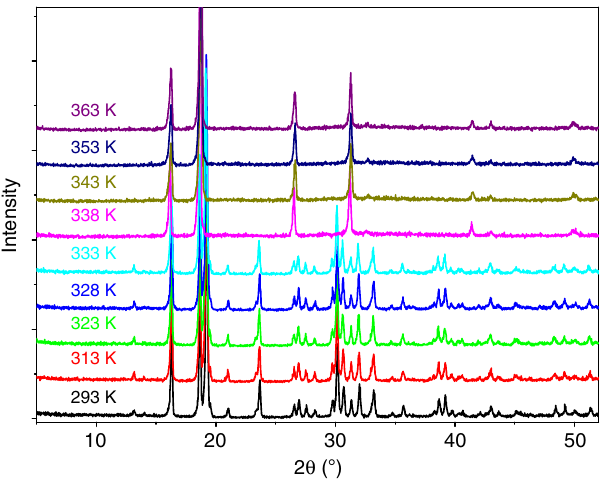
Figure 3 | Temperature-dependent PXRD of 1. The patterns of PXRD were recorded in a heating run. The significant change of the pattern was observed at 338 K.